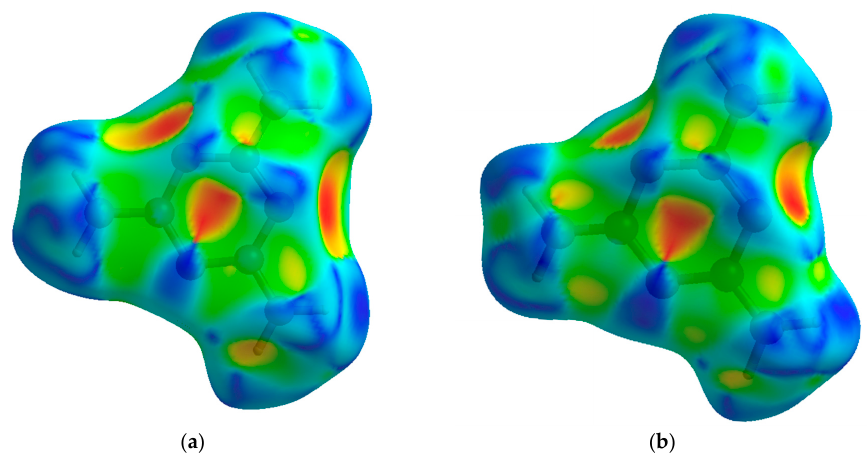
Figure 7. Hirshfeld surfaces displaying the shape index of melamine at low (0.96(5) GPa), ( a ) and high (36.21(5) GPa), ( b ) pressures. Concave areas, shown in red, correspond to areas where a complimentary neighboring molecule may interact.